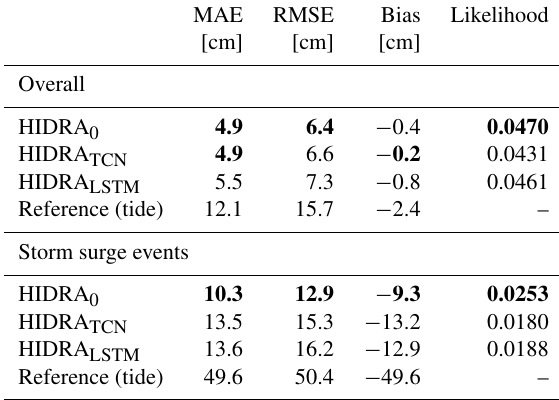
Table 5. Performance of HIDRA model variants using different temporal encoders. HIDRA 0 model uses fixed temporal attention for the atmospheric data. HIDRA TCN uses TCNs and HIDRA LSTM uses LSTMs to encode temporal features of atmospheric and sea level data. Performance of the astronomic tide is provided for refer- ence. The best result in each category is denoted in